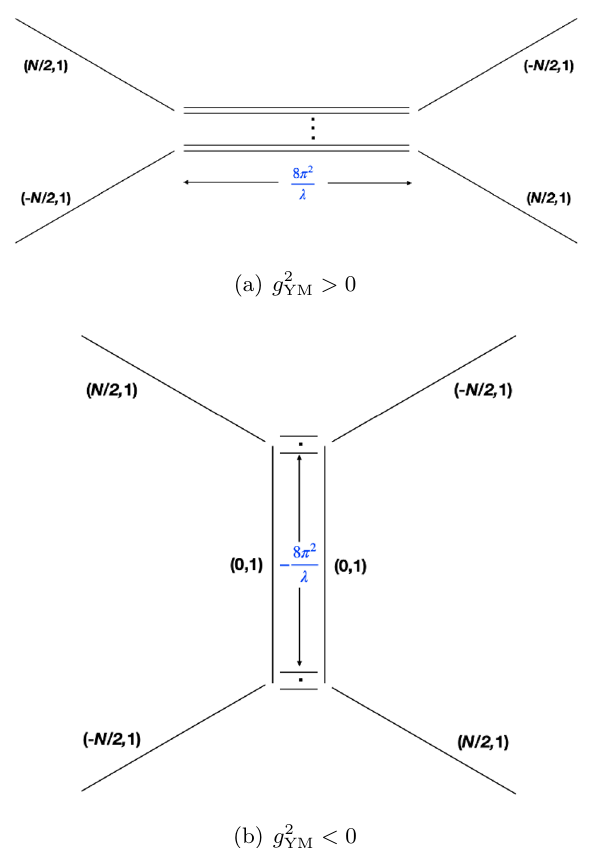
Figure 2 . ( p, q ) web for N = 1 SU( N ) gauge theory at positive and negative coupling with N even. The webs represent the origin of the Coulomb branch. At negative coupling the D5 branes split into two groups of N/ 2